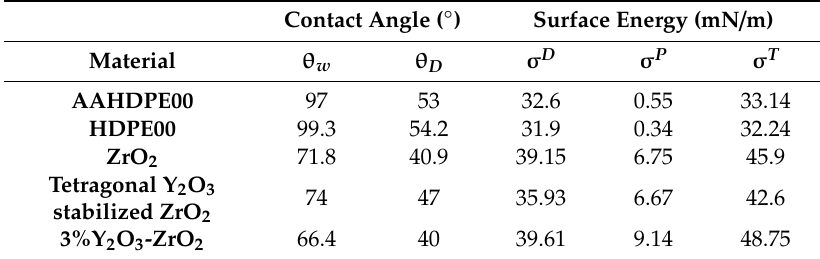
Table 4. Contact angle with water ( θ w and diiodomethane ( θ D ) measured for the polymers and values for zirconia as reported by Gonz á lez-Mart í n et al. [37]. The precision of all the contact angle measurements was within ± 2 ◦ . Polar ( σ P ) and disperse ( σ D ) components of the surface energy ( σ T ) calculated with Equation